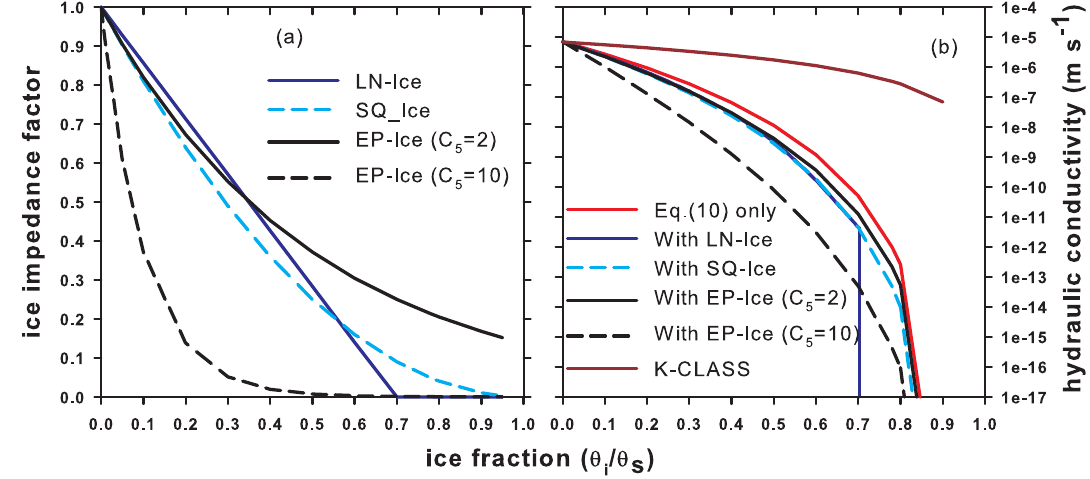
Fig. 4. Parameterisations of ice impedance factor (a) and their reductions to hydraulic conductivity when applied to Eq. (10). The soil hydraulic parameters used are as in Fig. 3d. Table 6. Observed and simulated infiltration (mm) by different algorithms, parameterisations and boundary inputs for three ground thawing stages at the three permafrost